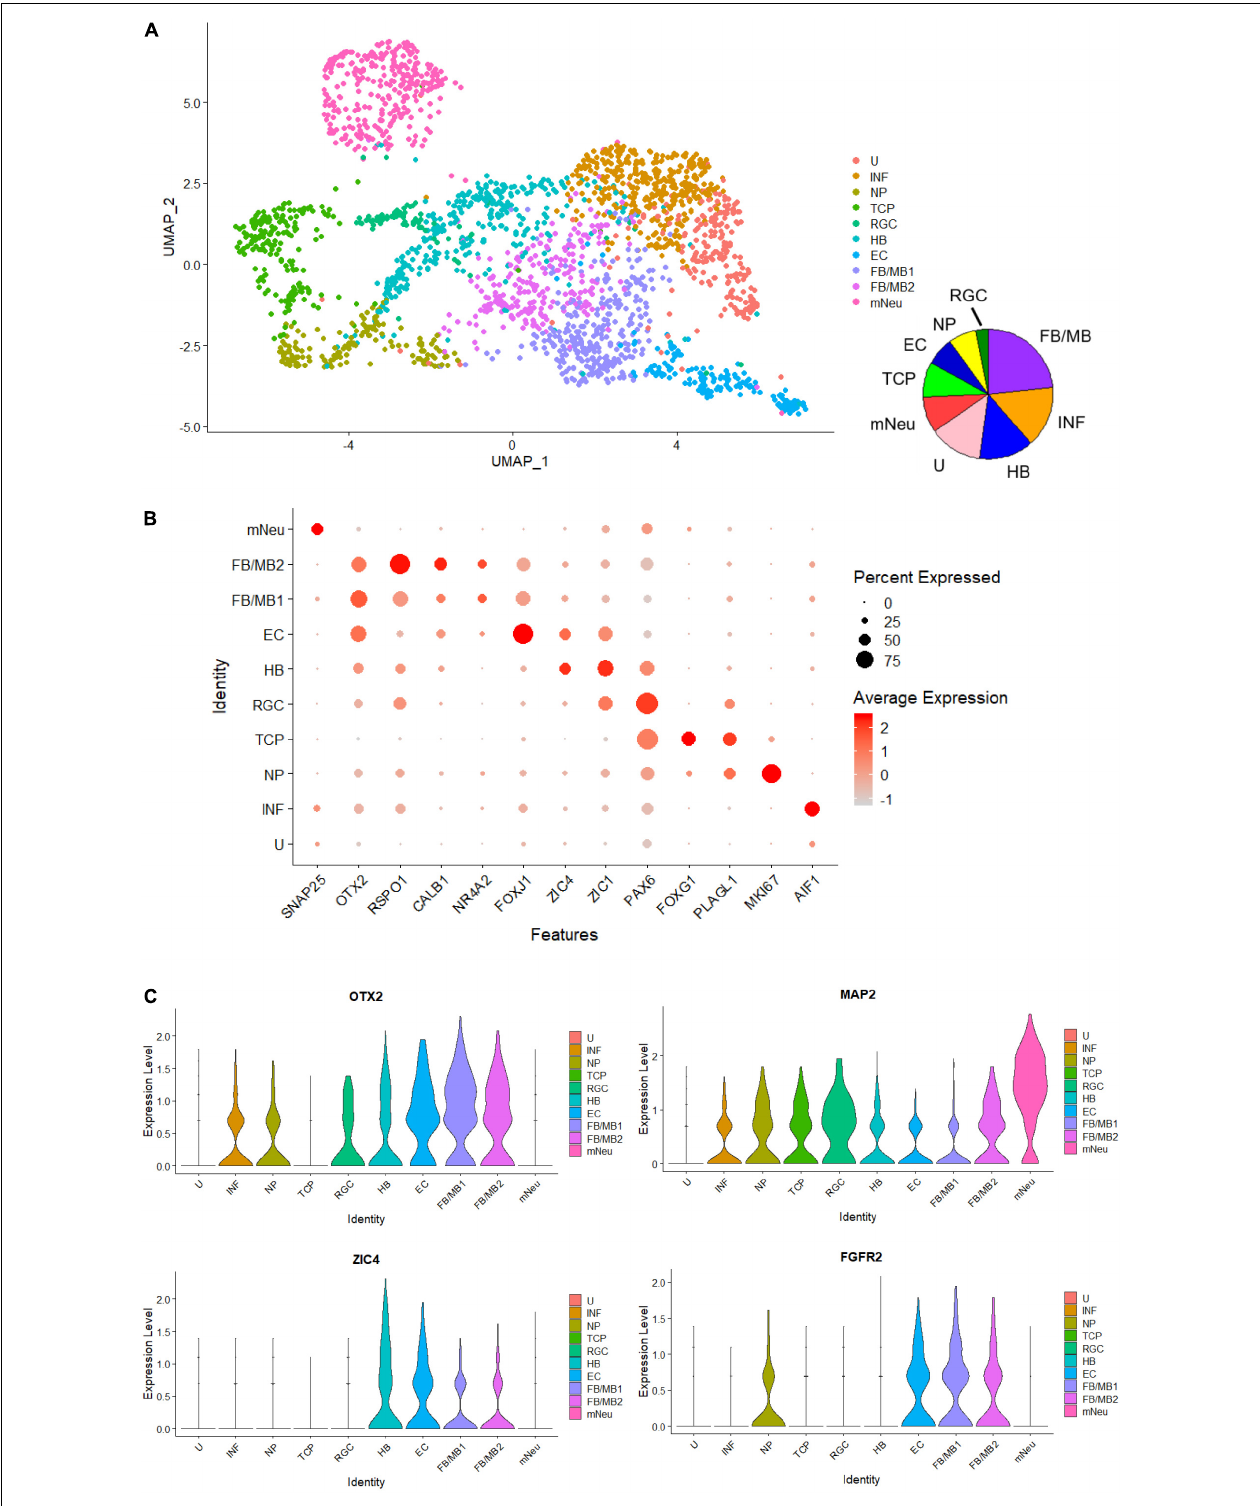
FIGURE 6 | Single-cell RNA-seq analysis of 1-month-old hBSOs from hESCs. (A) Unsupervised clustering of all cells from human brainstem organoids. INF; inflammation, NP; neuronal progenitors, TCP; telencephalic progenitors, RGC; radial glia cells, HB; hindbrain, EC; ependymal cells, FB/MB; forebrain and midbrain, mNeu; mature neurons, U; unknown. (B) Dot plots showing a selection of genes that identify cell population types. (C) Cell distribution plot of OTX2, FGFR2, ZIC4, and MAP2.